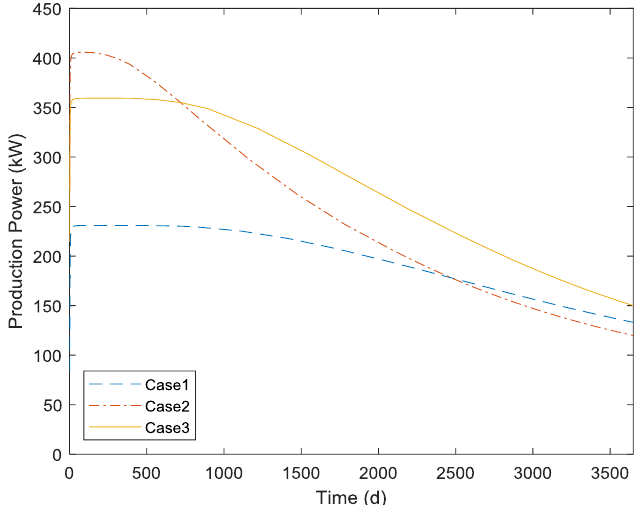
Figure 12. The production power in the three cases.